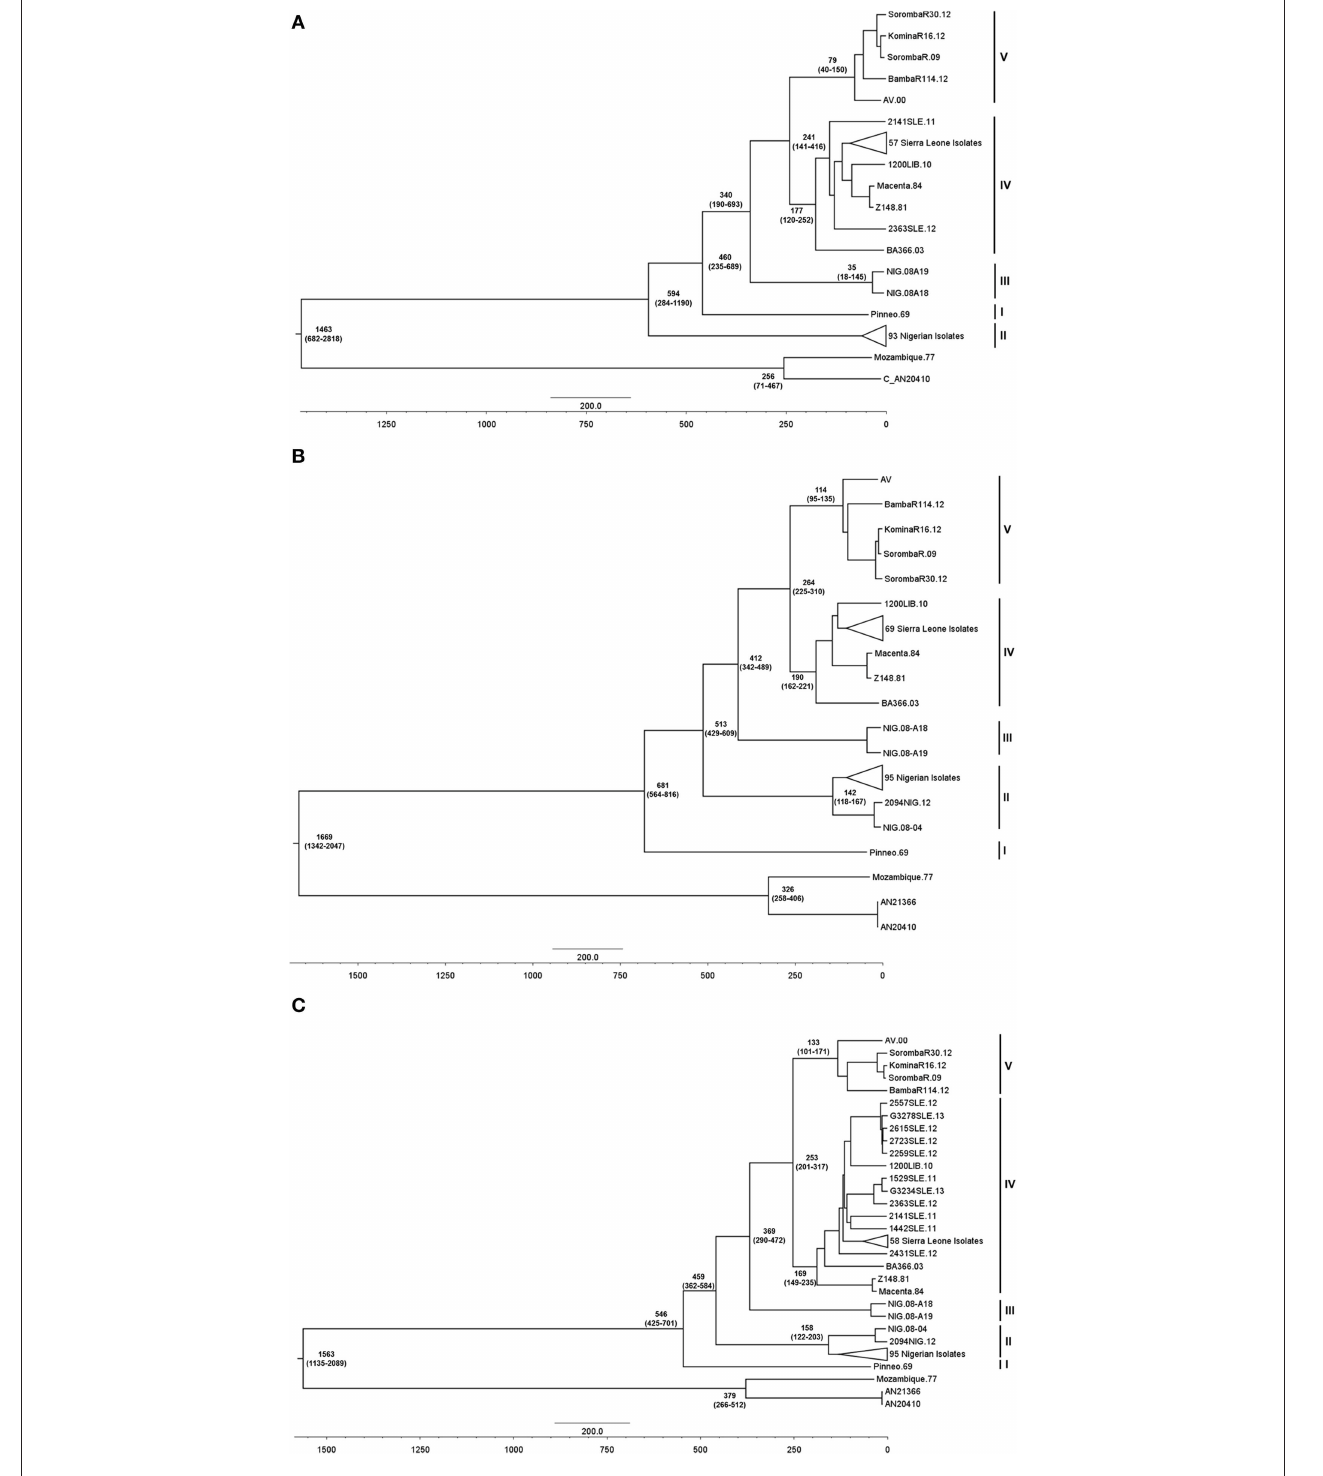
FIGURE 2 | BEAST analysis of complete LP, NP, and GPC nucleotide sequences. Complete open reading frames were aligned using MUSCLE, and analyzed using the Bayesian MCMC approach. The resulting trees for LP (A) , NP (B) , and GPC (C) were visualized using FigTree v1.4.2 and rooted using two representative Mopeia virus isolates. To better visualize distinct lineages, several Sierra Leonian and Nigerian isolates were collapsed, and these sections of the trees are provided in Figures S7–S12. The node ages, in years, are included on the major nodes, with the 95% confidence ranges displayed in parentheses below the median node ages. The isolates are grouped by their lineages, as represented by the bars to the right of the trees. The reverse axis represents the age, in years, from the most recent isolate.